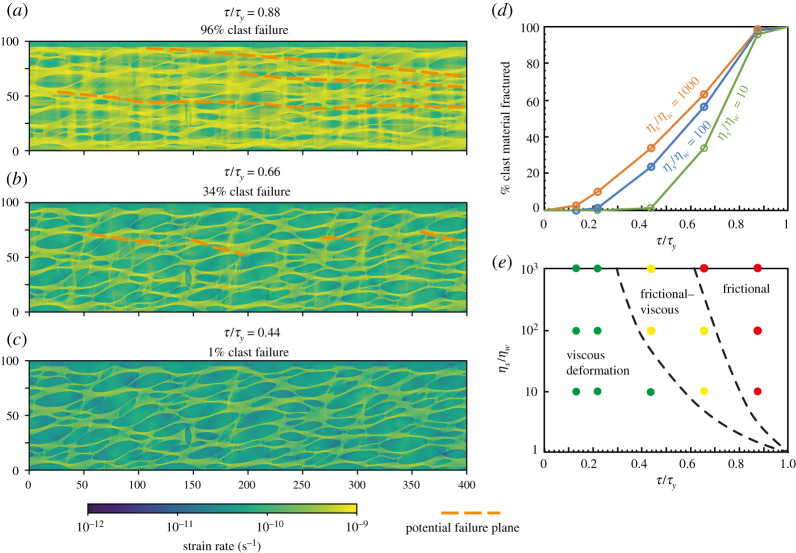
Plots of strain rate distribution within a linear-viscous shear zone where the viscosity ratio between clasts and matrix is 10. As in figure 4, the models are run at different ratios of driving stress (τ) to frictional yield strength (τy) of the competent phase, however, here the viscosity ratio is two orders of magnitude smaller. When τ/τy approaches 1 (a), 96% of clasts are yielding and frictional deformation dominates. There are multiple, potential through-going failure planes with lengths across the model domain. Compare this to a small τ/τy where here only 1% of clasts are failing frictionally (c), as opposed to 1/3 in the models with viscosity ratio of 103. In the intermediate case (b), only 34% of clasts are yielding, so that there is limited potential for short, discrete fractures to form, linking only few fracturing clasts through the matrix material. The data plots shown here, those in figure 4 and additional model runs are summarized in (d), whereas combined effects of τ/τy and the viscosity ratio ηs/ηw is illustrated in (e). In (e), points show where models were run, and depict viscous (less than 30% competent material fracturing), frictional–viscous (30–60% competent material fracturing) and frictional (greater than 60% competent material fracturing), respectively. Black dashed lines approximate fields by linear interpolation between calculated points.(Online version in colour.)